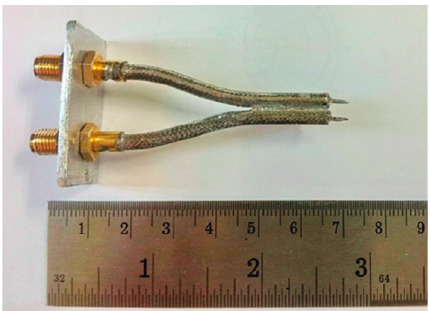
Figure 13: A photograph of differential probe.